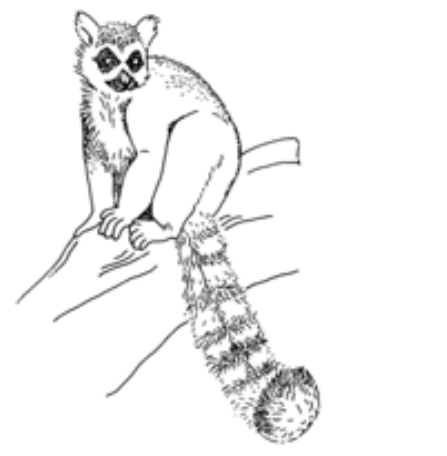
Box 2: Locomotor characteristics of ring-tailed